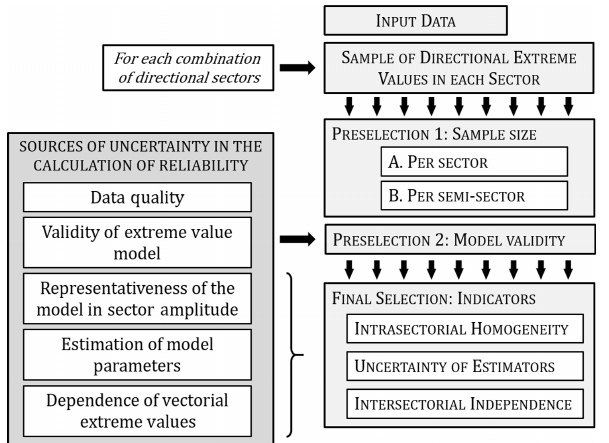
Figure 1. Methodology for sector definition, based on the sources of uncertainty in the calculation of reliability in a system subjected to directional extreme